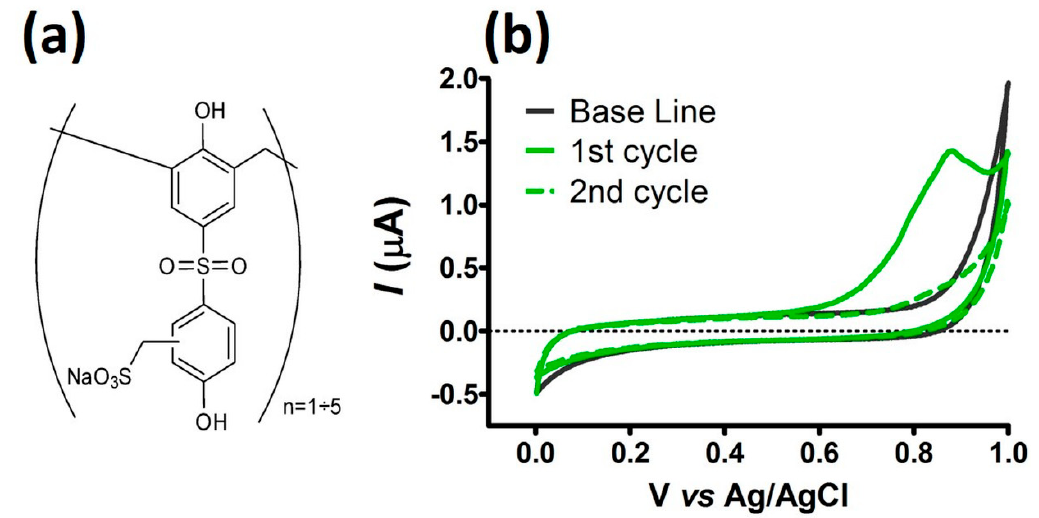
Figure 1. Chemical structure of Chemiplus 2DS HB ( a ). Cyclic voltammograms of Chemiplus 2DS HB on Pt-Ir in phosphate buffer (PBS, pH 7.4) (100 mV/s) ( b ): a base-line of current registered in phosphate-buffered saline (PBS) is shown as a solid dark grey line; a solid green line represents currents registered when 60 μ l of ChemiPlus 2DS HB was added into the electrochemical cell (1st cycle); the dotted green line is the current registered for the subsequent cycle (2nd cycle).